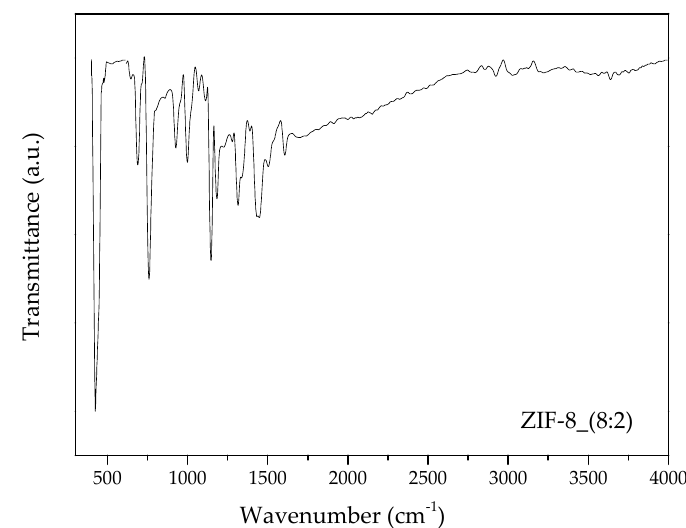
Figure 8. Fourier transform infrared (FTIR) of synthesized ZIF-8 obtained from optimal synthesis condition with the ratio between 2-MeIM and TMPAB as 8:2.